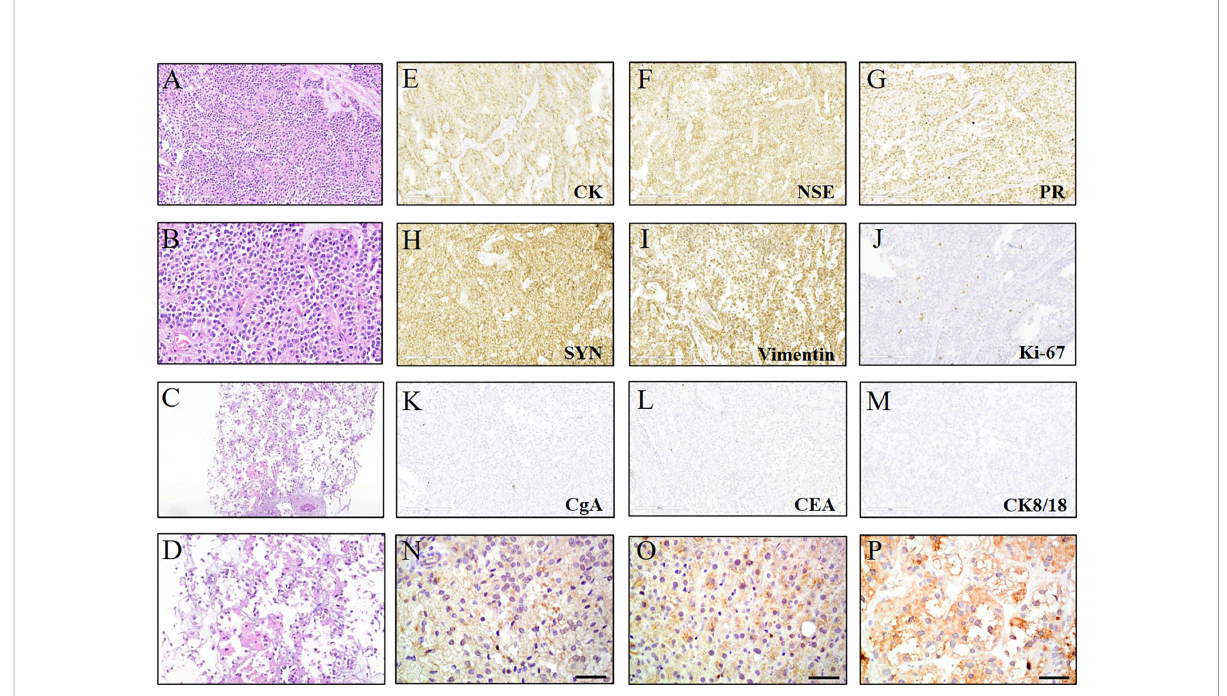
FIGURE 1 Hematoxylin & eosin (HE) and immunohistochemical (IHC) staining for the lesions. (A, B) HE staining (200× and 400×) of the primary solid pseudopapillary neoplasm (SPN) of the pancreas. (C, D) HE staining (100× and 200×) of the liver metastases at fi rst discovery. (E-M) IHC examinations (200×) of the SPN which was positive for cytokeratin (CK), neuron-speci fi c enolase (NSE), progesterone receptor (PR), synaptophysin (Syn) and Vimentin. The ki67 index was ≤ 5%, whereas negative for chromogranin A (CgA), carcinoembryonic antigen (CEA), cytokeratins 8 and 18 (CK8/18). (N-P) IHC staining (400×) of the primary pancreatic tissue and liver lesions showed the high expression of b